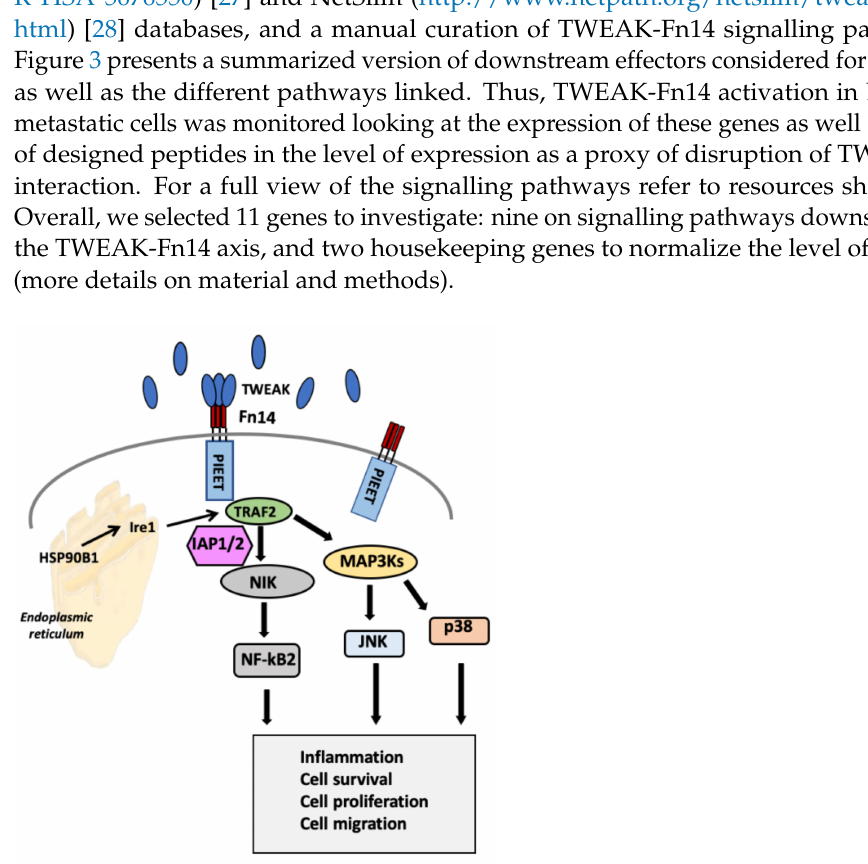
Figure 3. Simplified view of the TWEAK-Fn14 signalling pathway. The selection of the probe genes to be monitored upon treatment with peptides and/or TWEAK was based on the analysis of Reactome [27] and NetSlim [28] databases, and a manual curation of TWEAK-Fn14 signalling pathway [29]. Downstream TWEAK-Fn14 activation complex, recruitment of the TRAF cofactor molecules, through NIK stabilization, engages ERSRP and non-canonical activation of NFkB. MAP3Ks cascades activation lead JNK (c-Jun N-terminal kinase) and engagement of p38 (MAPK14), which results in their translocation to the nucleus, wherein they modulate gene